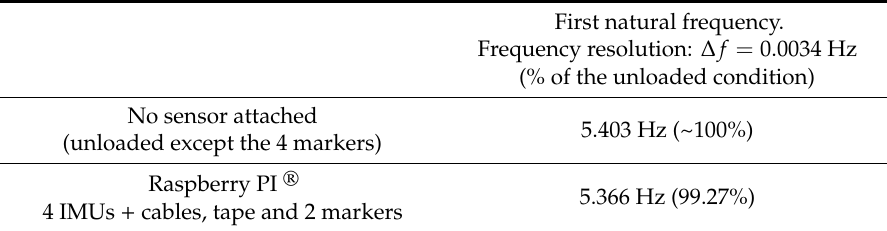
Table 3. First linear natural frequency for the unloaded and sensor-loaded conditions. First natural